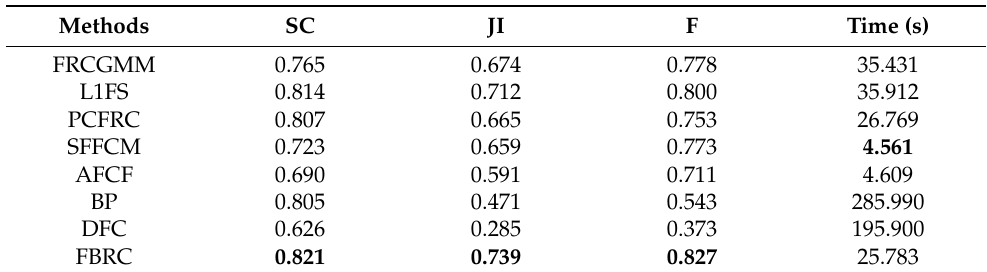
Table 2. Quantitative comparisons of various approaches for PH2 database. The best results are highlighted in